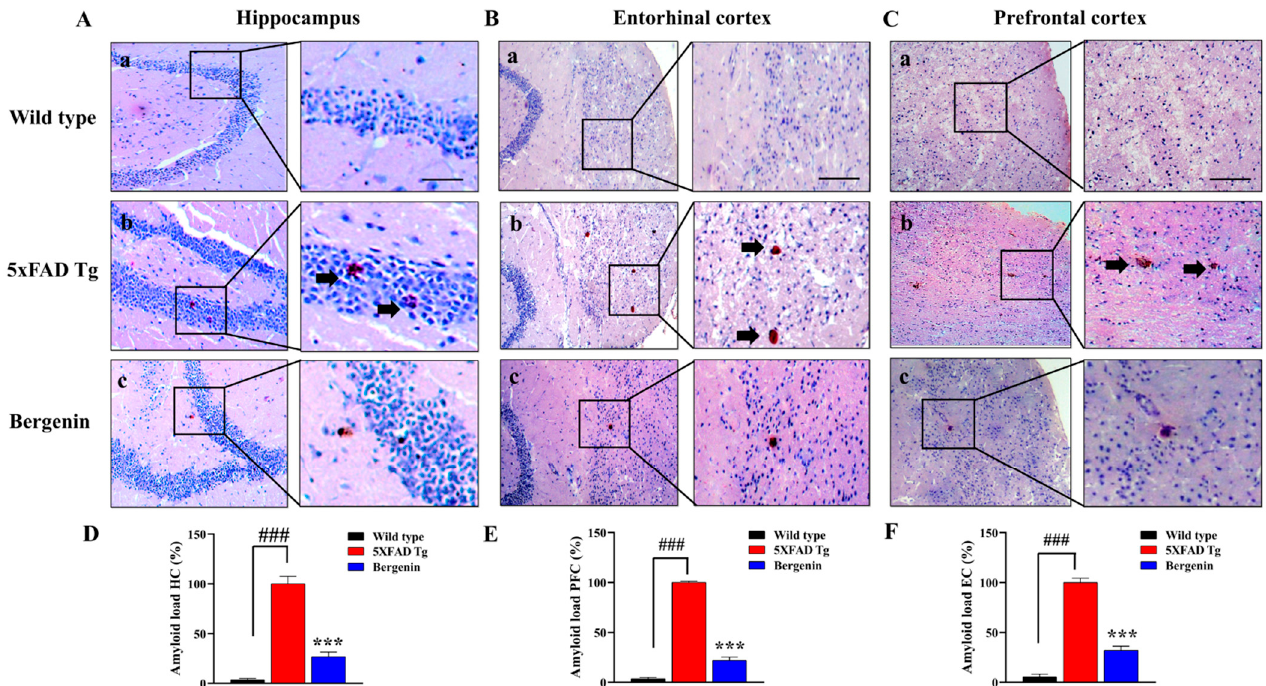
Figure 5. Bergenin (60 mg/kg) demonstrated a decrease in amyloid load (arrows) in all the regions of interest. Representative photomicrographs of dentate gyrus region of the hippocampus, entorhinal cortex, and prefrontal cortex in ( a ) wild-type, ( b ) 5xFAD Tg, and ( c ) Bergenin-treated groups stained with Congo red. Scale bar = 50 µ m. ( D – F ) Quantitative analysis was performed, results were expressed as mean ± S.D ( n = 3). *** p < 0.001 versus the 5xFAD Tg group, ### p < 0.001 versus the wild-type group.